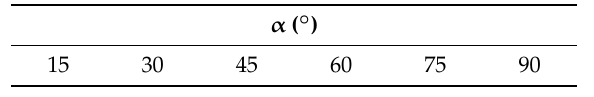
Table 2. Cross-section reductions in extrusions with single-pass dies ( R T ). Table 1. Die semi-angles in extrusions with single-pass dies ( α ).